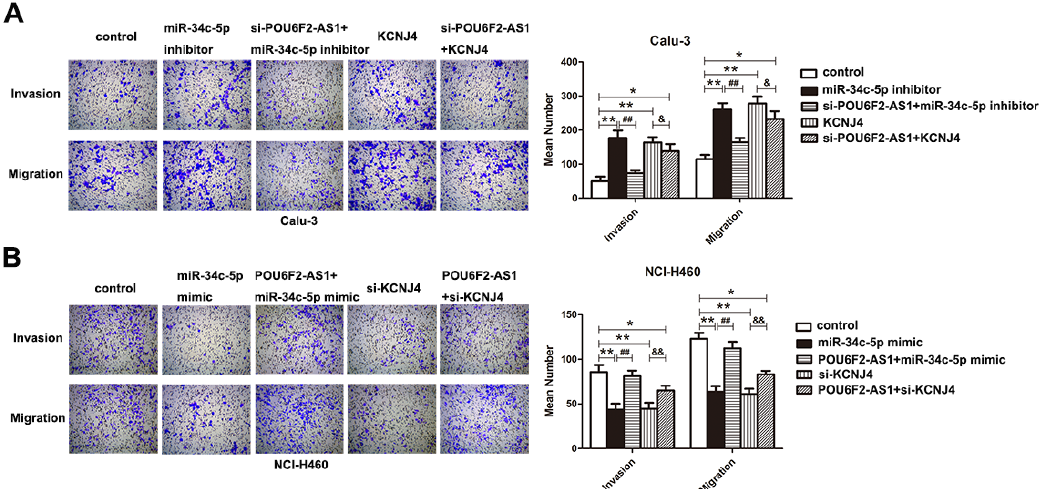
Figure 5 – Effect of POU6F2-AS1 on invasion and migration of LADC cells was recovered by miR-34c-5p via targeting KCNJ4. (A) and (B) Transwell experiments were performed utilizing Calu-3 and NCI-H460 cells. *P < 0.05, **P < 0.01, ## P < 0.01 and && P < 0.01.